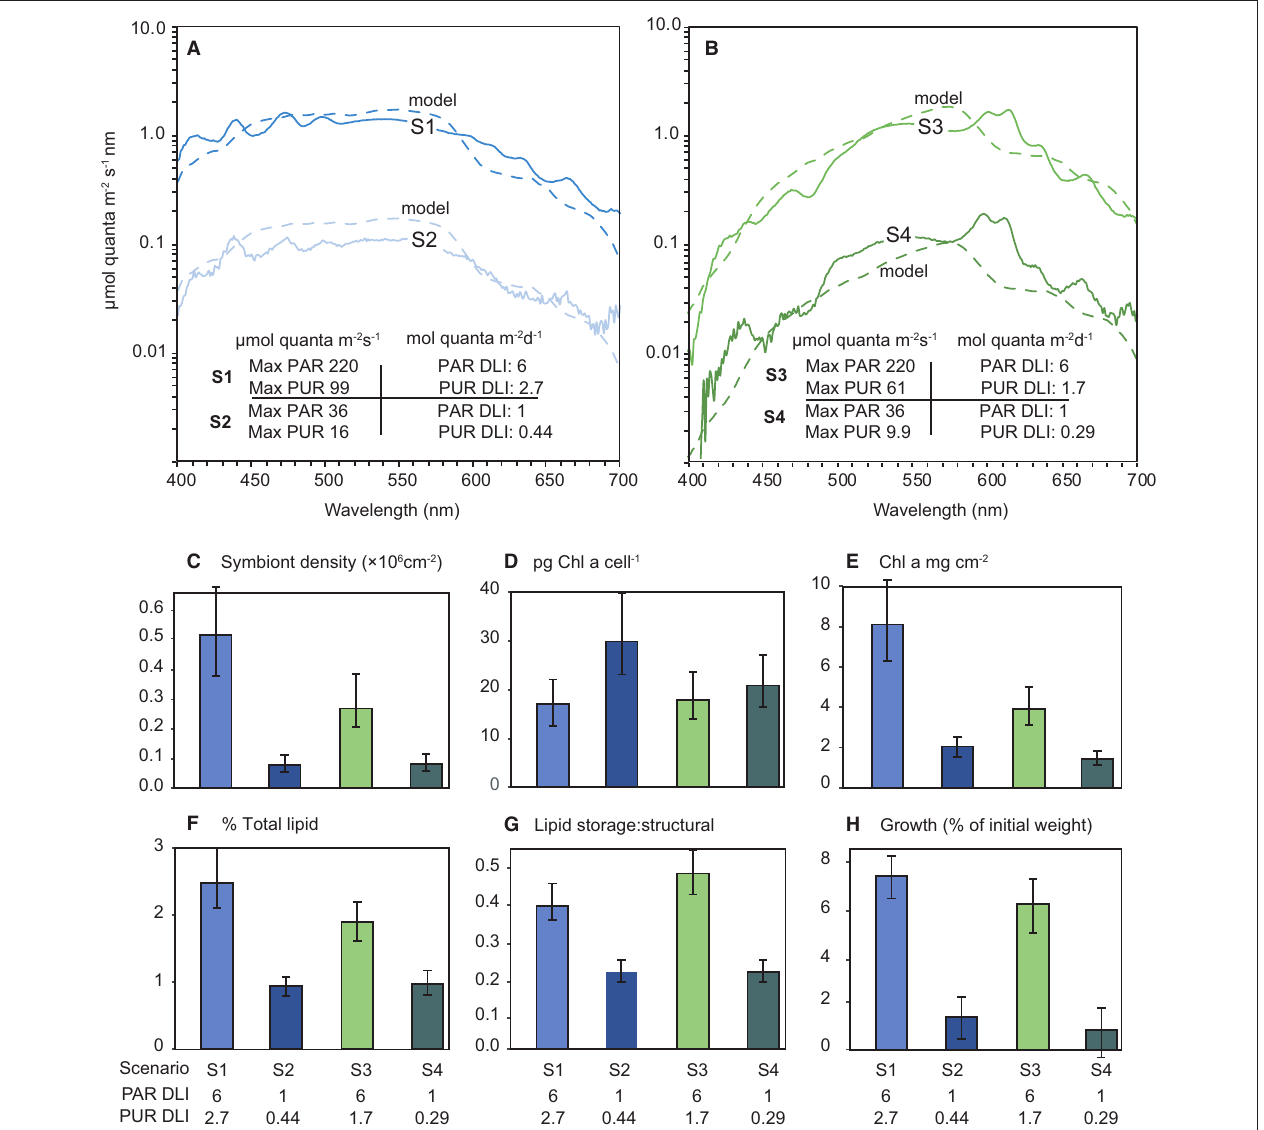
FIGURE 9 | (A,B) Modelled (dashed lines) and measured (solid lines) irradiance ( µ mol quanta m − 2 s − 1 nm − 1 ) profiles during the 28-d laboratory experiment with the coral Pocillopora verrucosa . The spectral profiles mimic light quantity and spectral quality at 5m depth (cloud-free days) and a zenith angle of 19 ◦ (at solar noon) derived from empirical solar irradiance model and correspond to light levels expected under SSCs of 0.5 and 10mg L − 1 . Numbers in the figures represent the four light treatments used expressed as maximum (12 noon) PAR or PUR as µ mol quanta m − 2 s − 1 , and daily light integral (mol quanta m 2 ) from the sinusoidal ramping up and down over the 12h light cycle, (C–H) Mean and 95% confidence intervals for each response variable over the 4 light